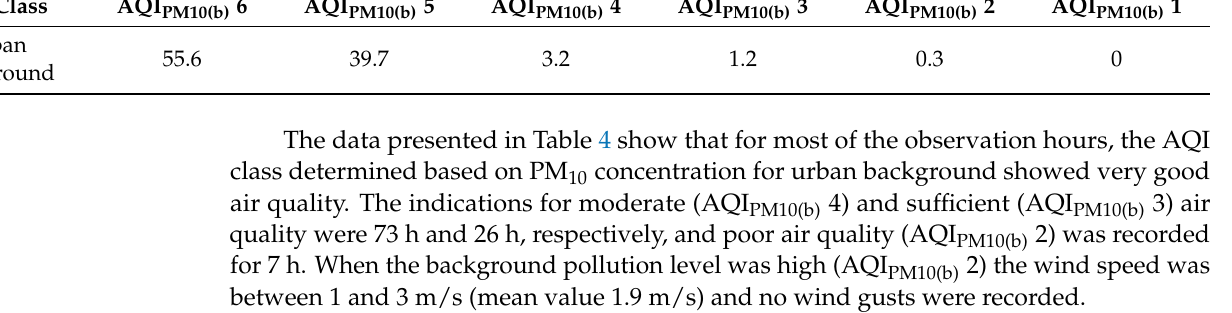
Table 4. Occurrence rates of air quality index classes for urban PM 10 background.